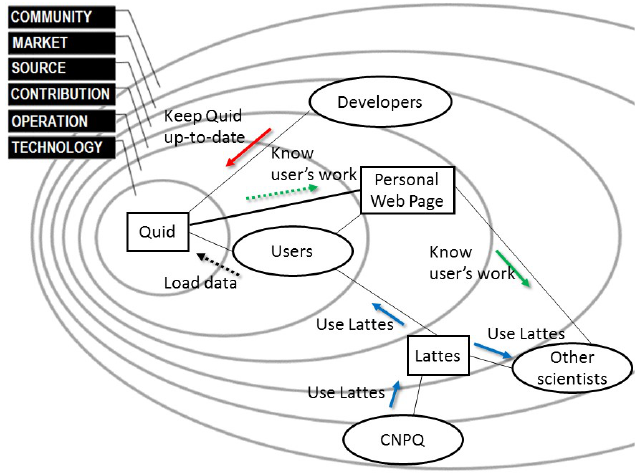
Fig. 23. The association between Quid and the personal web page of its users reconfigures the network of actors, allowing other paths for interests. Quid is acting as a